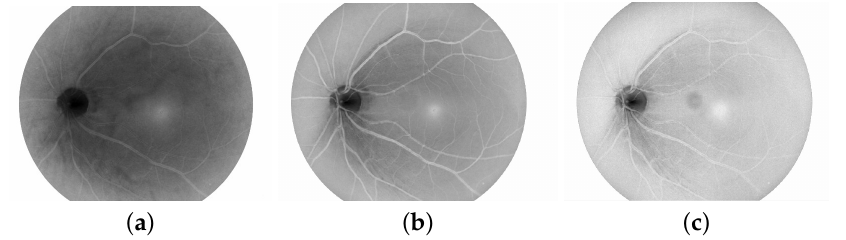
Figure 3. RGB Images Inversion ( a ) Inverted Red-Channel ( b ) Inverted Green-Channel ( c ) Inverted Blue-Channel.